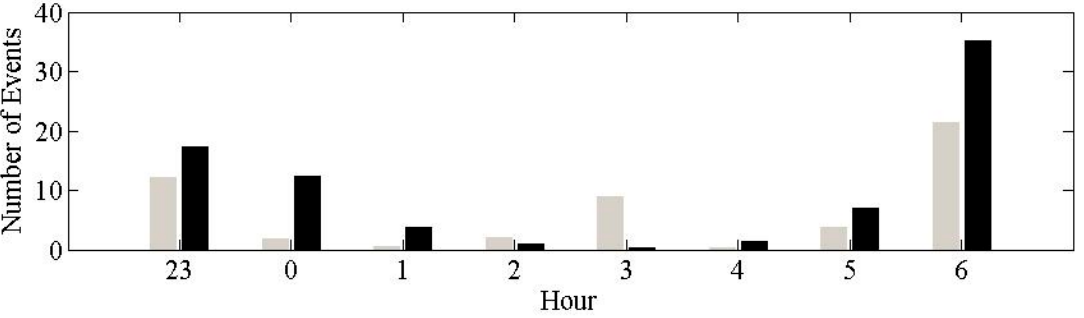
Figure 1. Average number of hourly operations at Philadelphia International Airport (PHL) based on 68 nights of modeled data (period June 2012 to September 2012). Departures (gray) and arrivals (black).